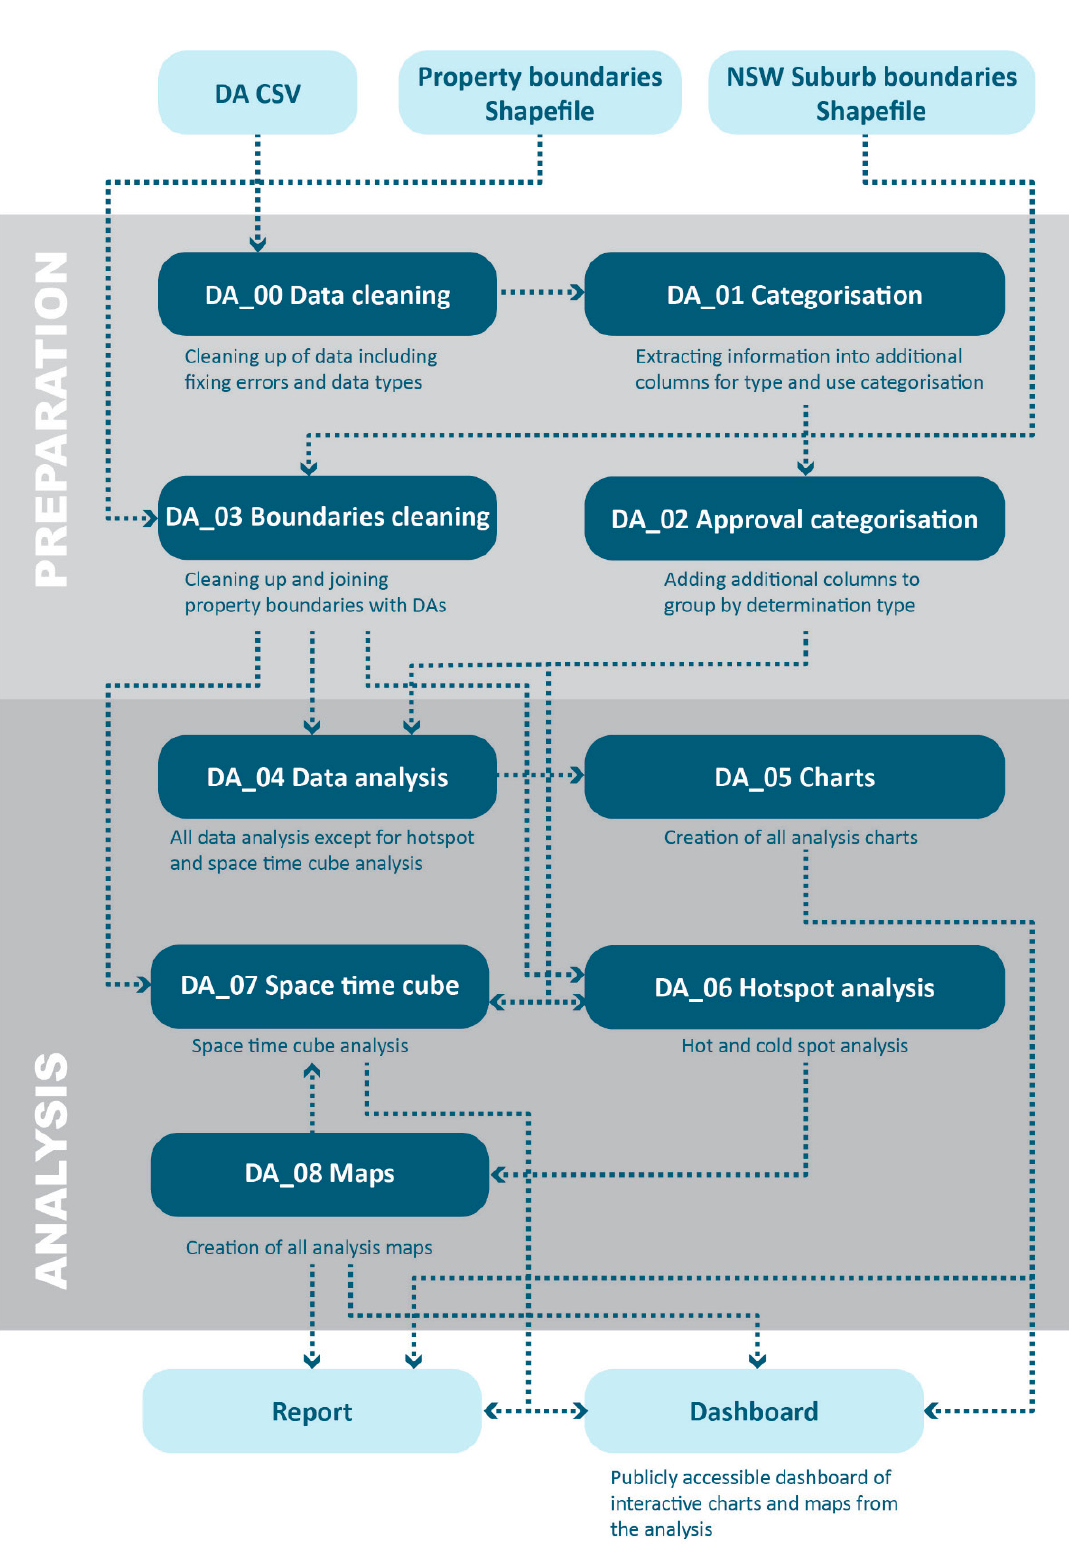
Figure 6. Illustration of overall workflow in Jupyter notebook.